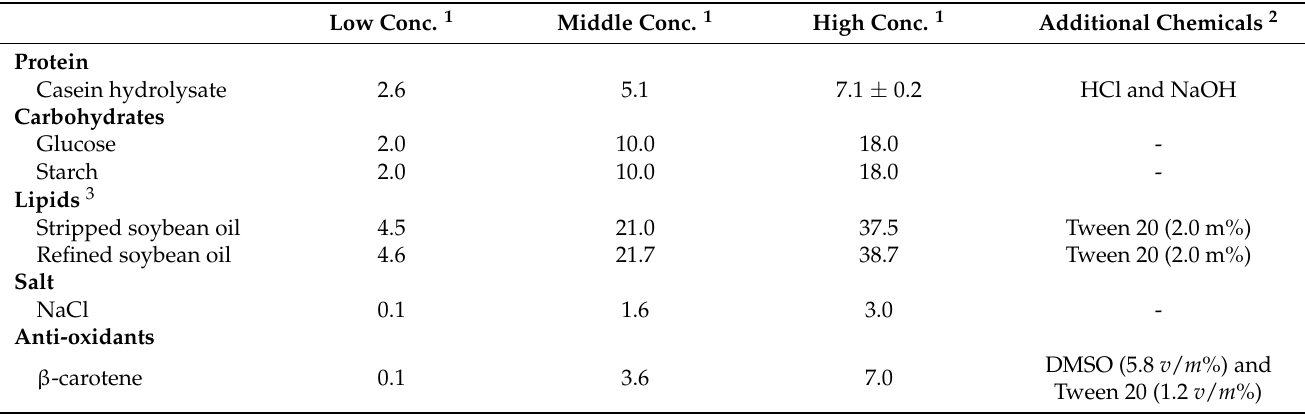
Table 1. Concentrations of the food matrix components in the supplemented agar media applied in this study based on their presence in real-life food products. Seven different components from five classes (indicated in bold) were added to the